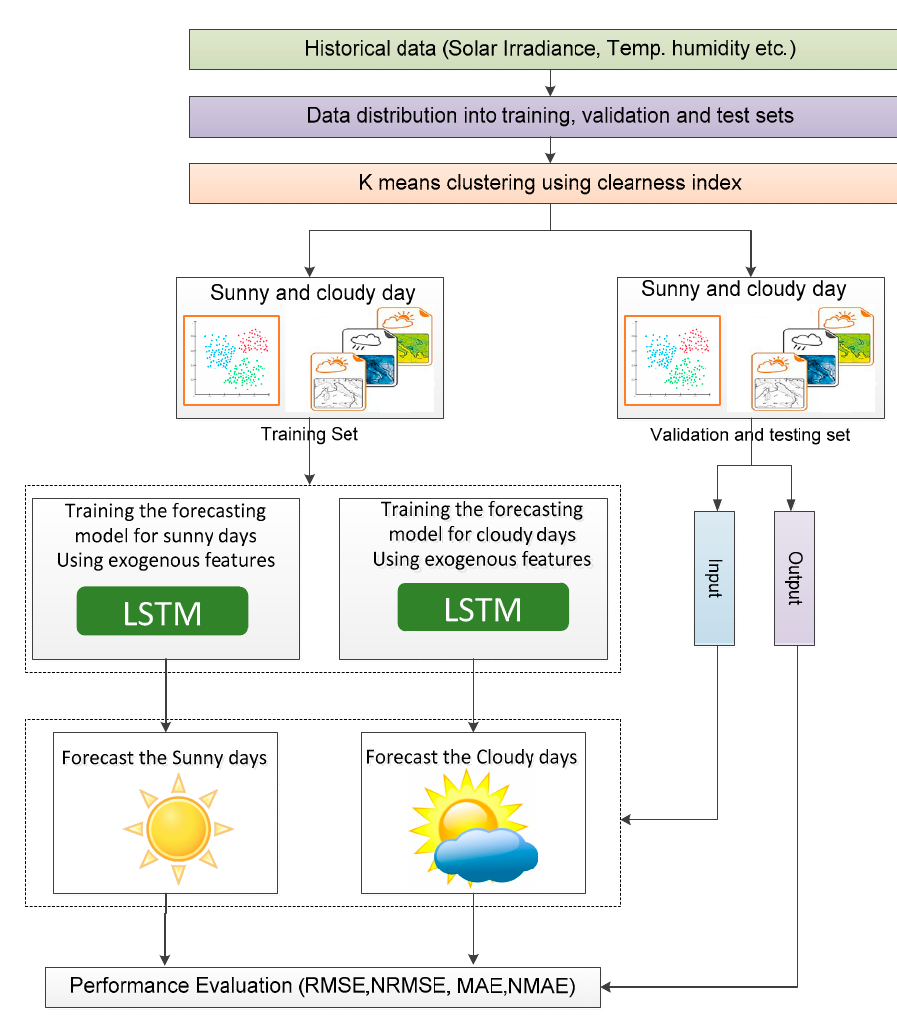
Figure 3. The proposed hybrid approach for SI forecasting.